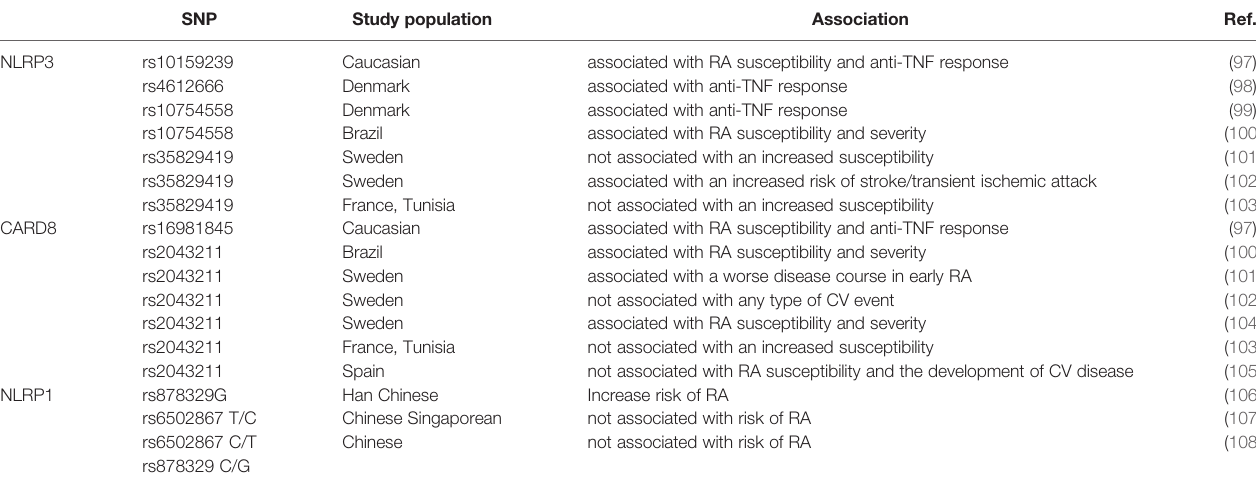
TABLE 1 | The relationship between in fl ammasome SNPs and